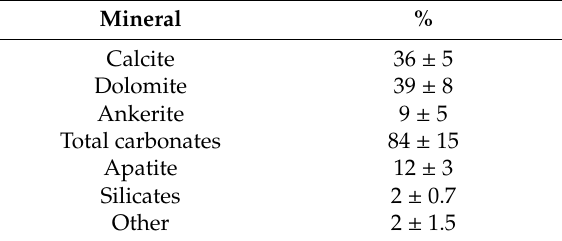
Table 3. Estimated mineral contents of the CC (average ± standard deviation of 10 measurements). Mineral %